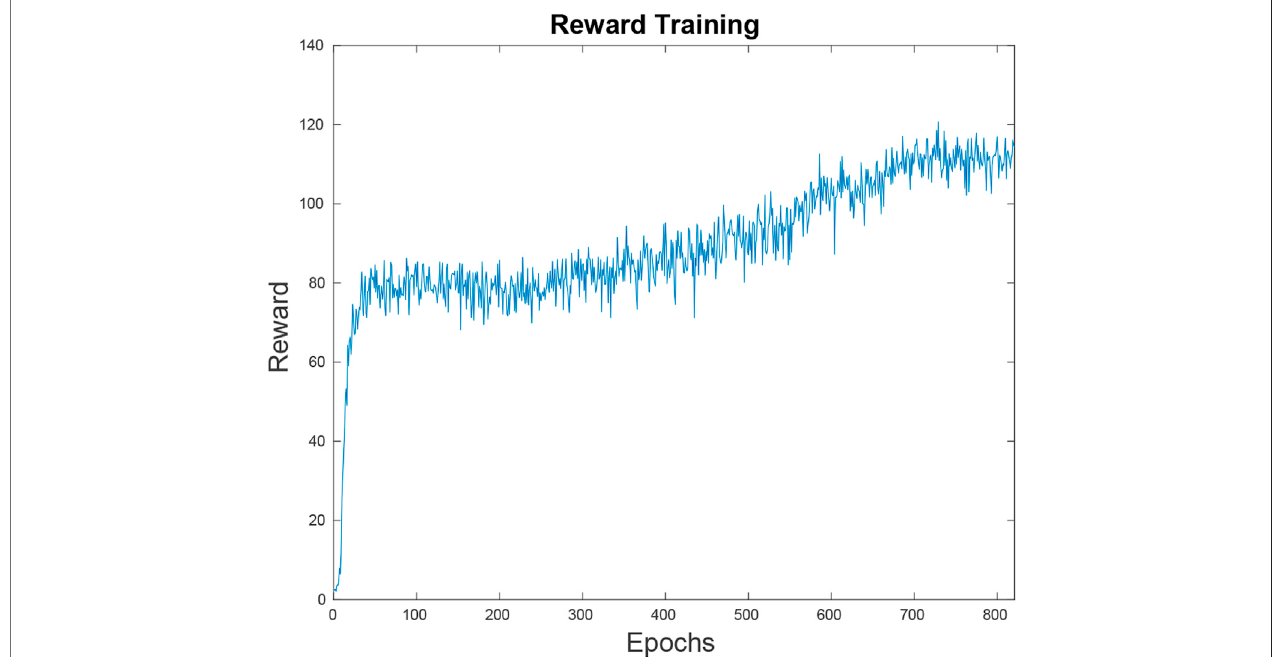
FIGURE 4 | This fi gure depicts the neural net ’ s reward function, or the inverted loss function over the training time. Within the fi rst 80 epochs the neural net has reached anaveragerewardof80 U on random simulations.Atthis point itisoutperforming arandom path plannerbut the results are notcompetitive.Sincethelearning has hit a plateau, it takes 500 more epochs to bridge the gap to the point where it is performing at the level shown in Figure 11 .